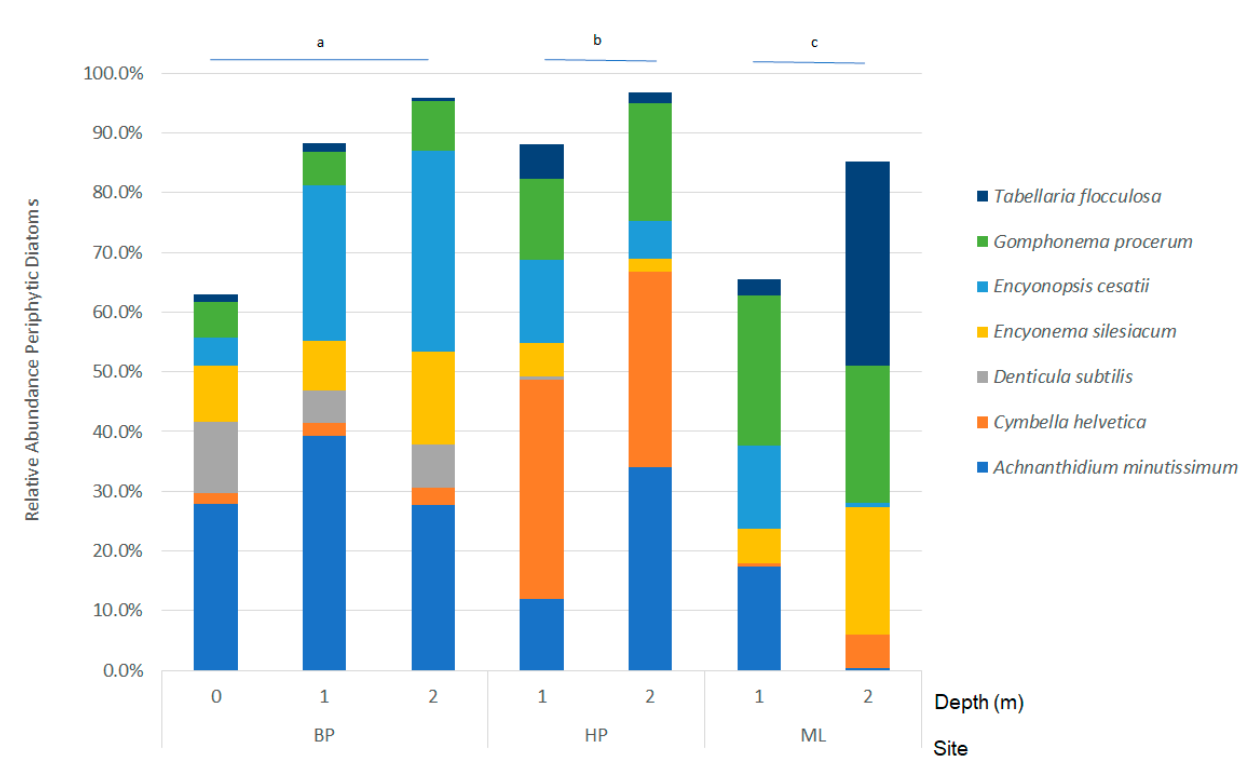
Figure 4. Relative abundances of periphytic diatoms identified using similarity of percentages (SIMPER) as contributing greater than 50% of differences between sites (BP—Brunette Park, HP—Hunter’s Point, ML—McLain State Park). Letters above site bars indicate significance ( p < 0.05) following post-hoc, pairwise Adonis with Holm’s adjustment.